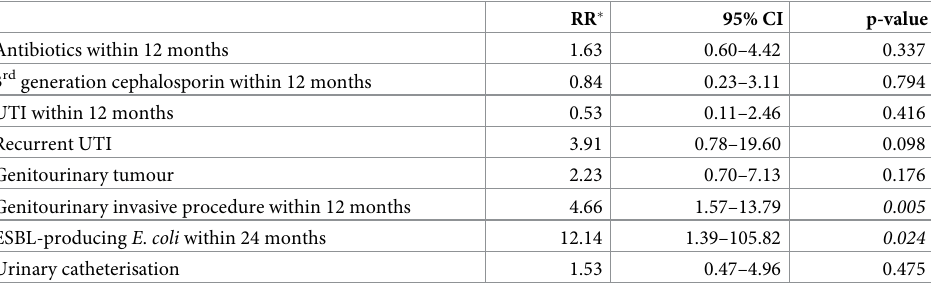
Table 2. Multivariable analysis of risk factors for ESBL-producing UPEC a